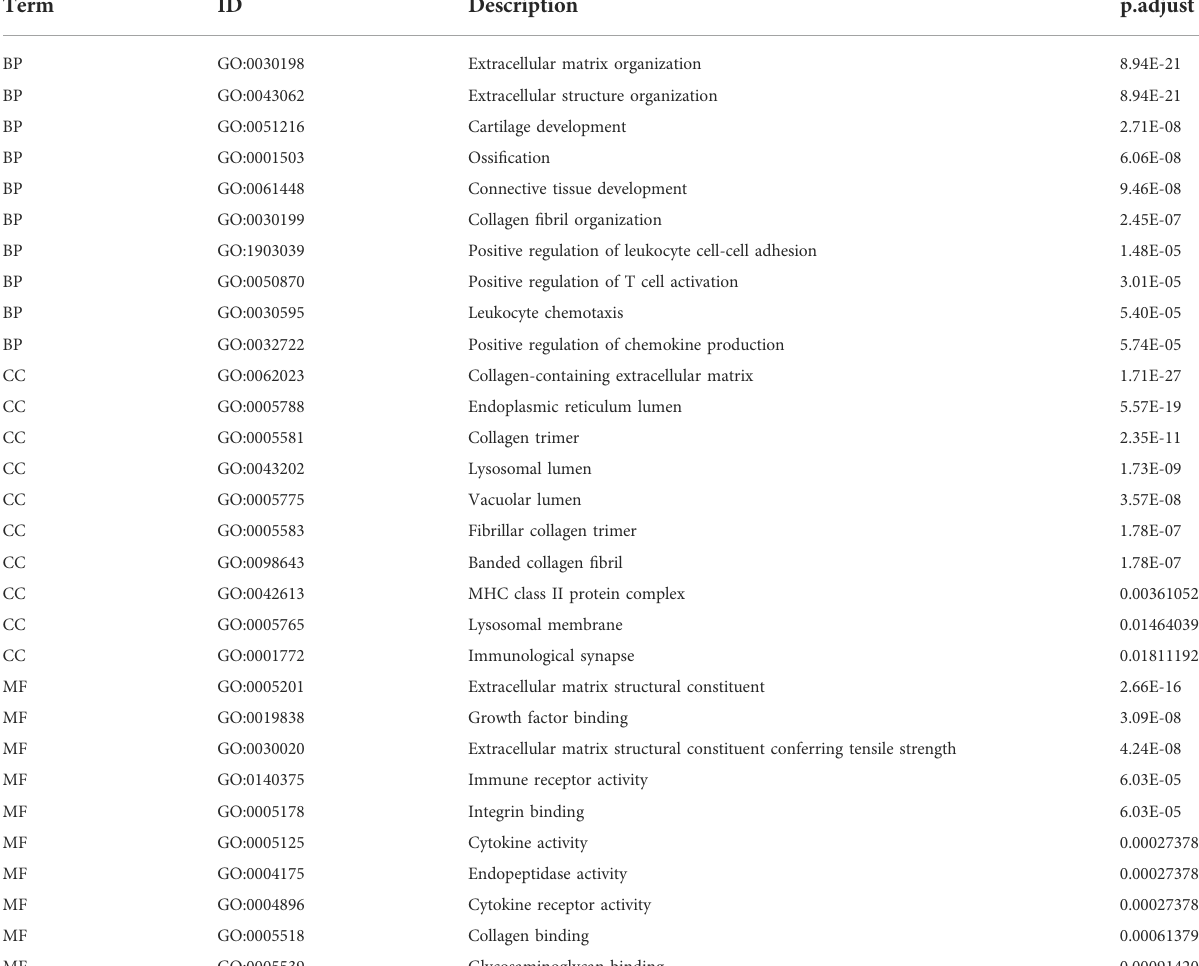
TABLE 3 GO enrichment analysis of